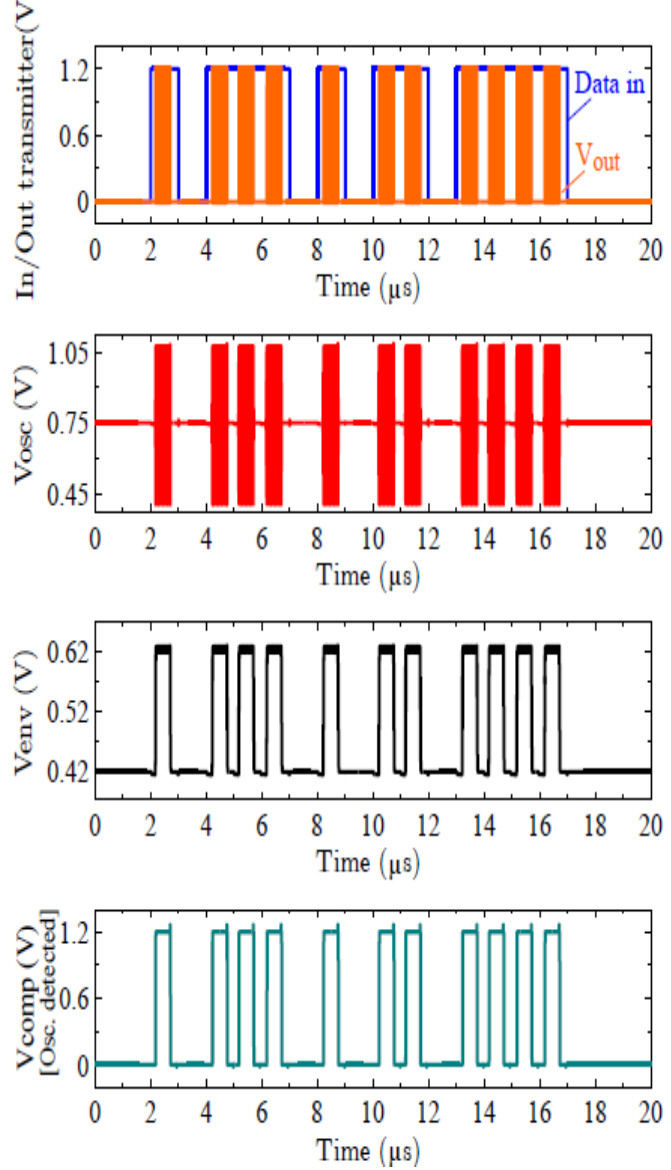
Figure 16. System performance for random input data at 1 Mbps to the proposed transmitter with quench frequency 1 MHz. Table 2. Simulation results of the entire quench